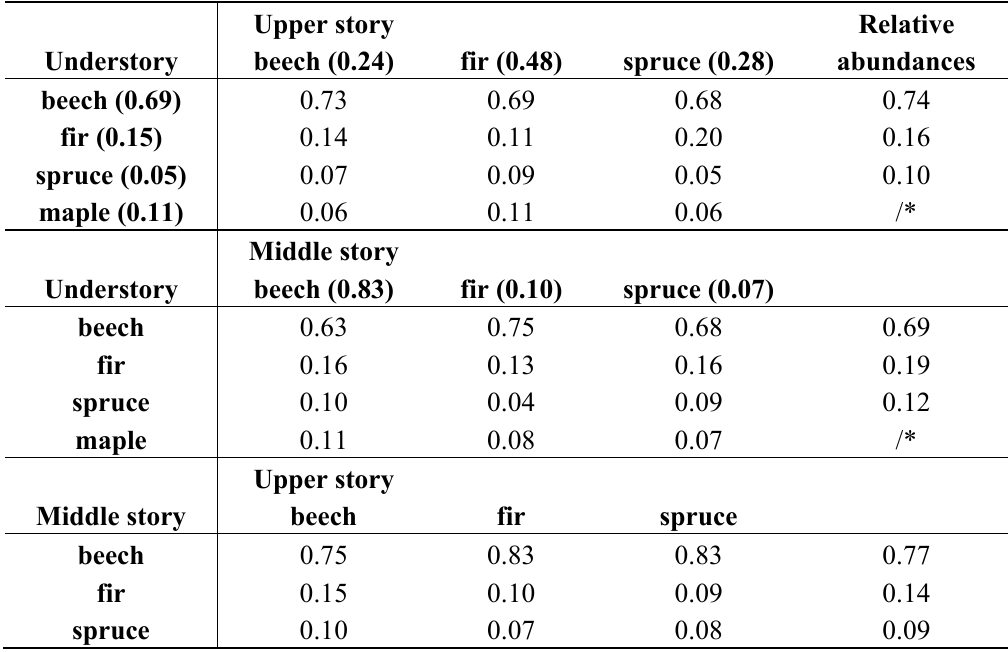
Table 4. Transition probabilities of species between three canopy stories, based on 40 sample plots. Present species mixture in individual stories is given in parentheses next to the species. Relative abundances of the species after 20 generations are listed in the far right column.